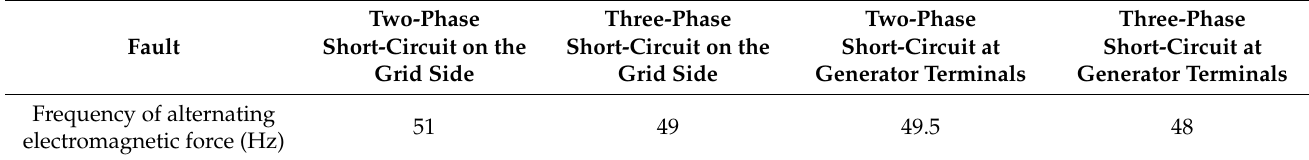
Table 5. Known value under 80% load of generator.